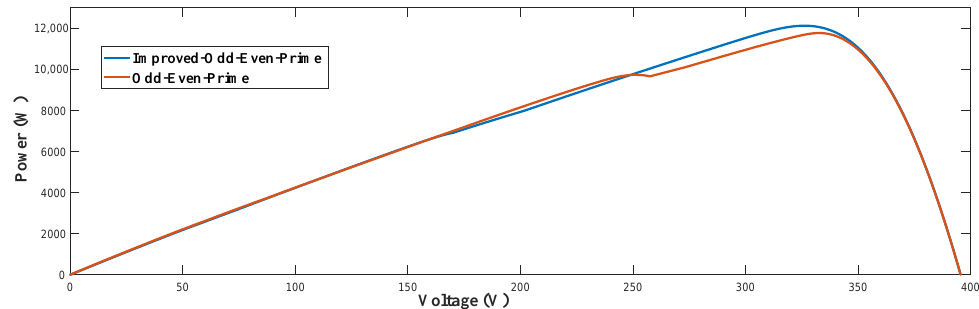
Figure 3. Voltage–power characteristics of 9 × 9 PV array for case-1 (Top-Left) PSC.